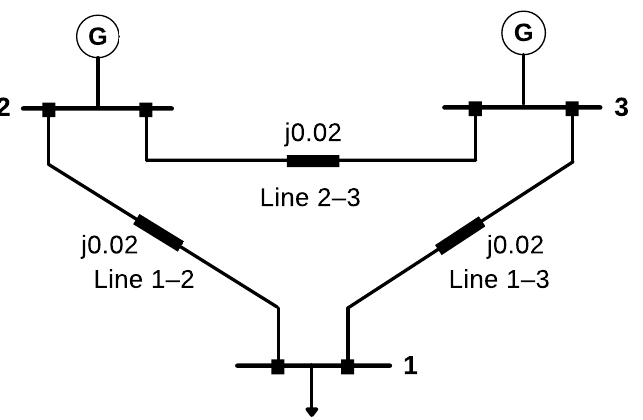
Figure 3 . Example network for BTF calculation . Figure 3. Example network for BTF calculation.